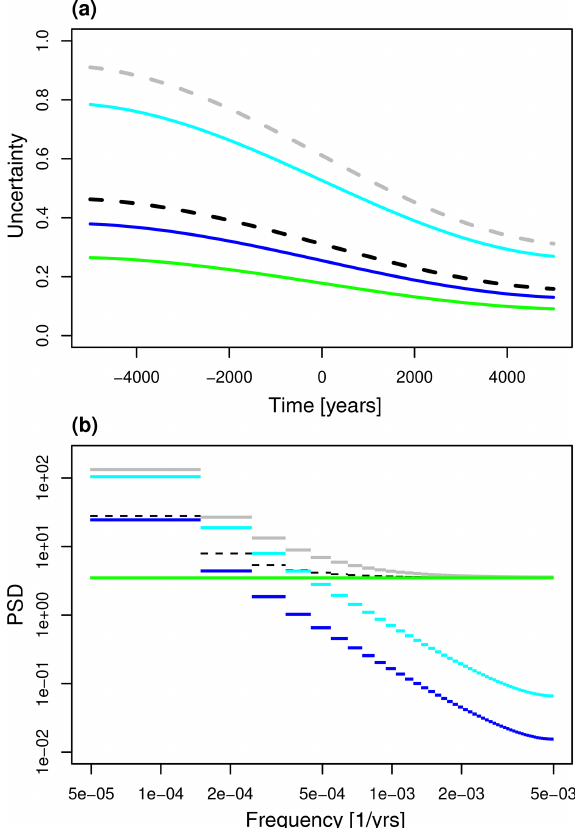
Figure 6. Example of the reconstruction uncertainty based on the deterministic component Y ( t ) of the supposed true climate signal. (a) Time series of the reconstruction bias B n (cyan line), of the uncertainty components U (3) ,n (blue line) and U (4) ,n (green line), ] 1 / 2 (dashed black line), and [ B 2 + U 2 ] 1 / 2 (dashed of [ U 2 n (3 , 4) ,n (3 , 4) ,n gray line). (b) Power spectral densities of the corresponding error components: S B ,m (cyan line), S U (blue line), S U (green (3) ,m (4) ,m line), S U (dashed black line), and S B , U (gray (3 , 4) ,m (3 , 4) ,m